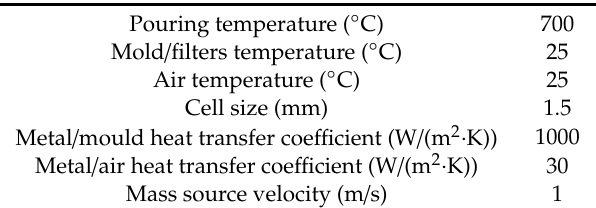
Table 1. Simulation parameters.